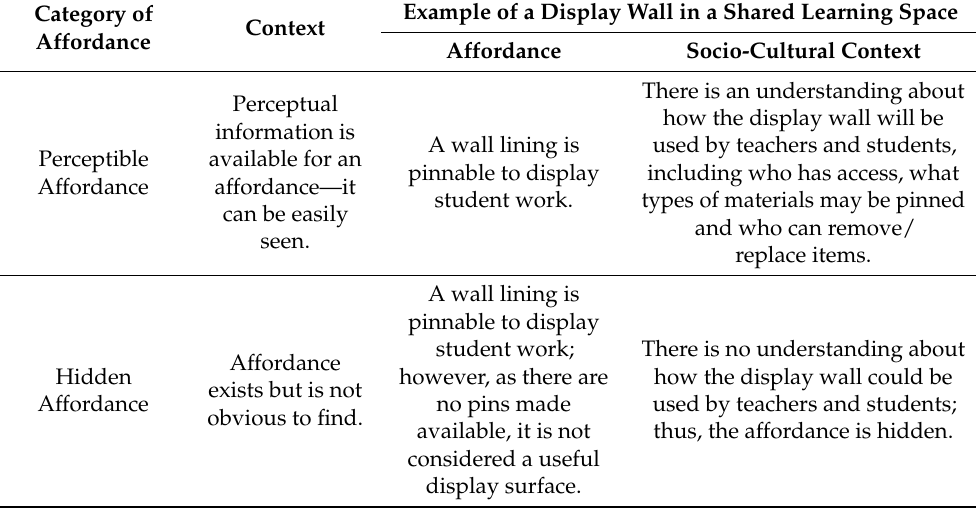
Table 1. Perceptible and hidden affordances in a learning space as influenced by socio-cultural context—the example of a pinnable wall